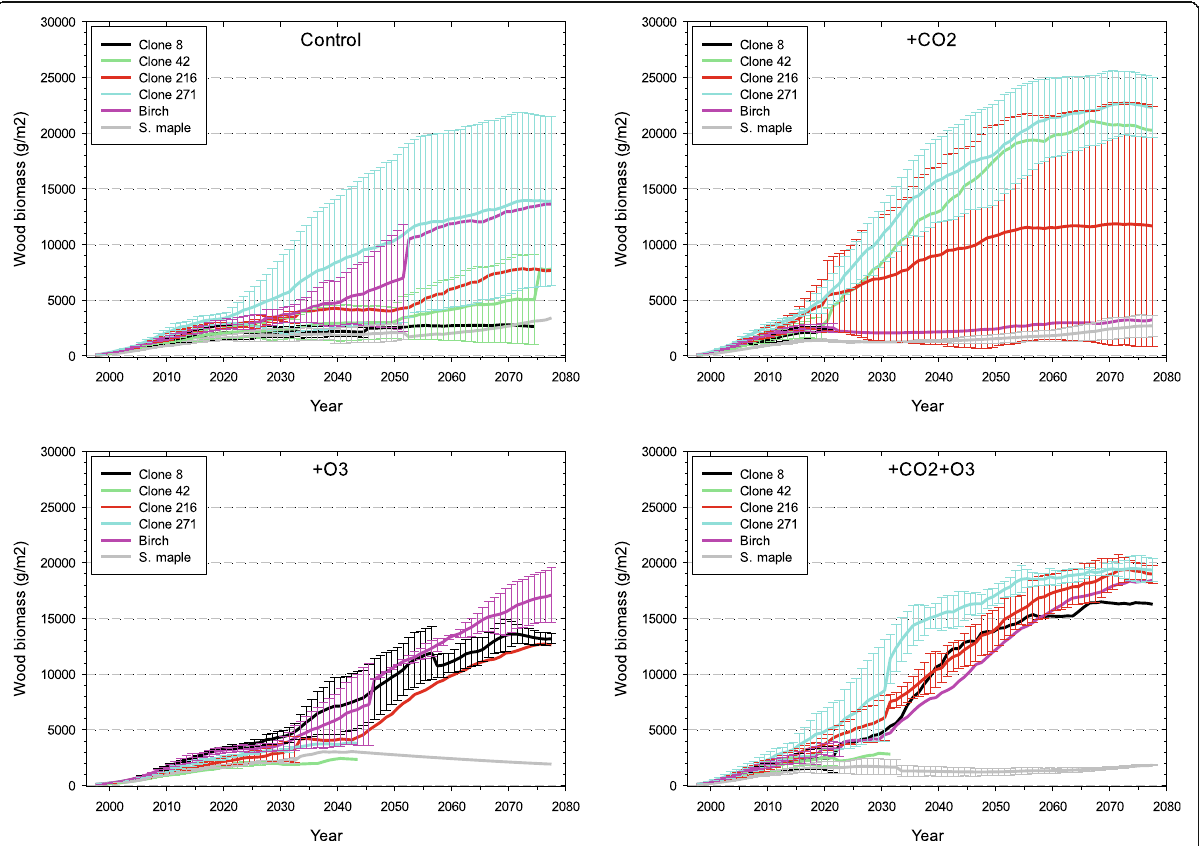
Fig. 8 Extrapolation by simulation 80 years into the future of all six Aspen-FACE experiment taxa together. Error bars show one standard deviation of three replicates, and a taxon survived in only one replicate where there are no error